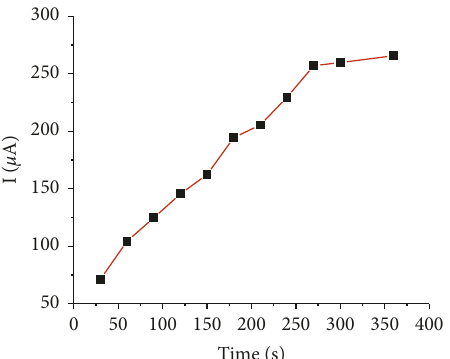
Figure 12: Accumulation time effect on the current signals of 100nM Cd(II). Supporting electrolyte solution: B-R solution of pH 4; accumulation potential: − 1.0V; amplitude: 100mV; frequency: 80Hz; and step potential: 6mV.